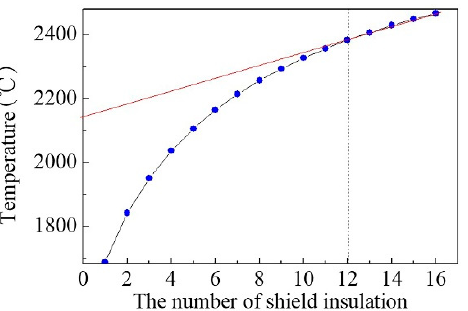
Figure 4. The highest-temperature profile of the crucible with insulation layers with different numbers.